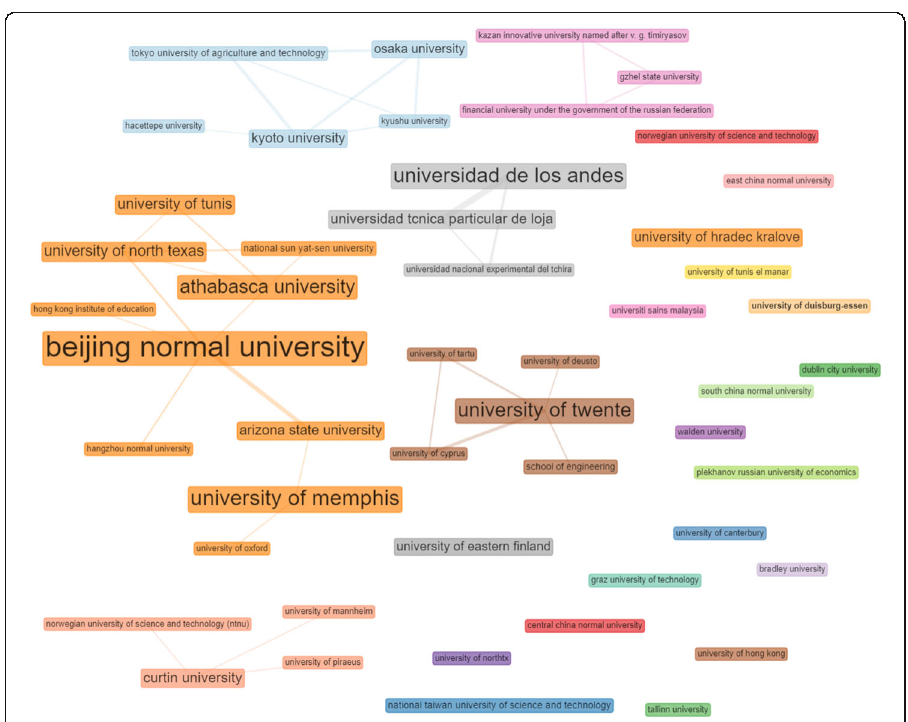
Fig. 7 Mapping of institutions collaboration and social networks: clearly, institutions with a bigger network of collaborations are boldened while those with a few networks or none are